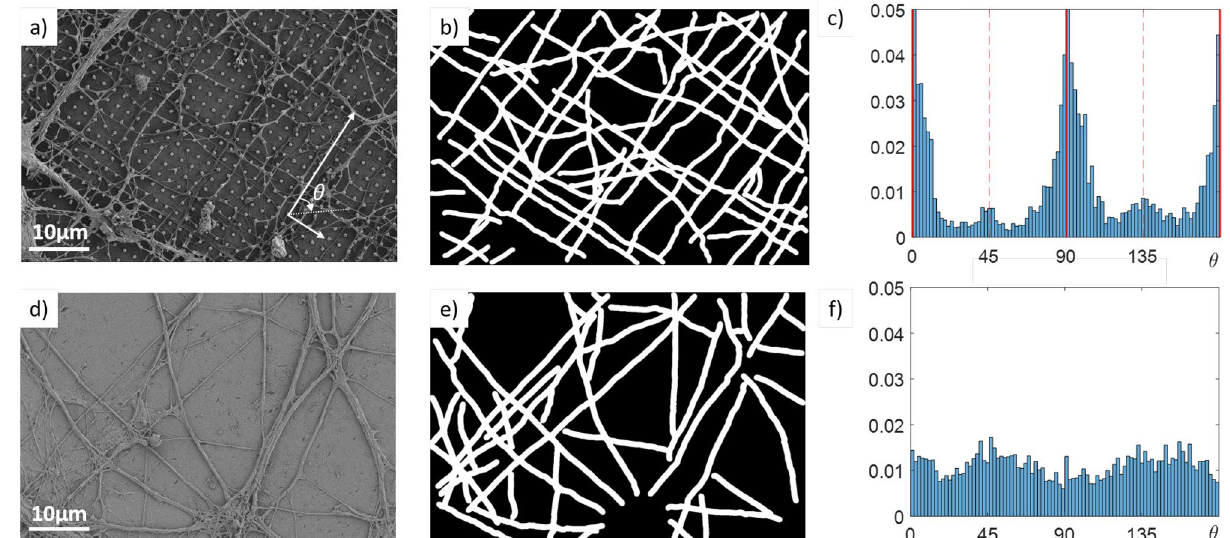
Figure 5. Preferential growth direction of primary hippocampal neurons neurites on nanopillar arrays. The first row ( a–c ) refers to a nanostructured substrate ( d = 300 nm, p = 2 µ m), the second row ( d–f ) to a flat surface. ( a,d ) SEM images at × 4.5k magnification. ( b,e ) Neurites detected using NeuronJ. ( c,f ) Histograms reporting the axon direction with respect to one of the main axis of the grid, as illustrated in panel ( a ). Red lines mark the two perpendicular directions along nearest neighbors of the array. Each histogram is obtained analysing 15 images.